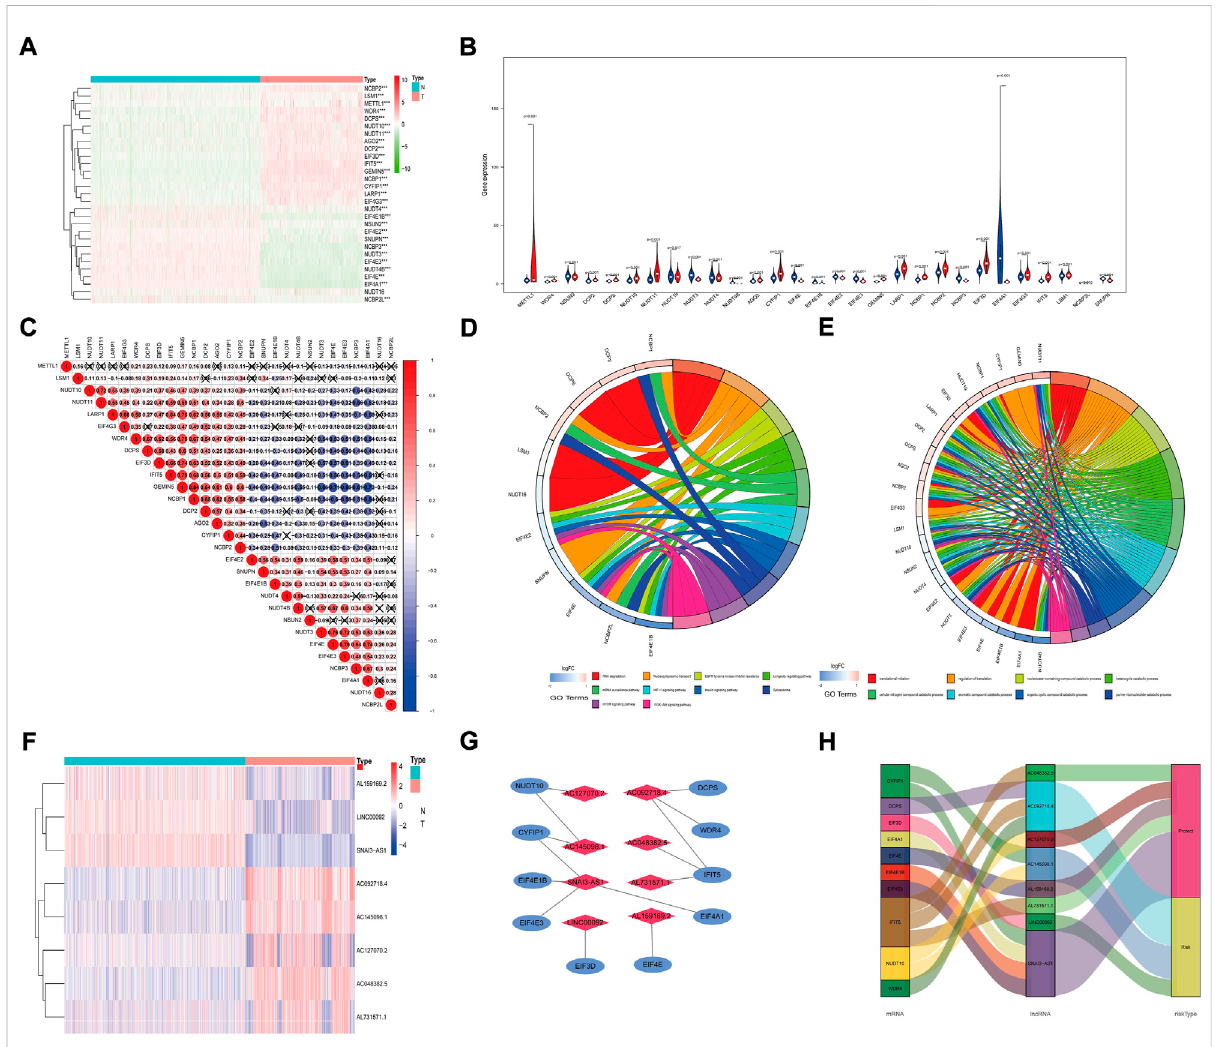
FIGURE 1 Expression of m 7 G-related mRNAs and prognostic m 7 G-Related lncRNAs. (A) Heat Map shows the expression levels of eight m 7 G-related mRNAs. (B) The vioplot shows the differentially m 7 G-related mRNAs. Blue represents normal sample, and red represents the glioma sample. (C) Spearmancorrelationanalysisofm 7 G-relatedmRNAs. (D) KEGGcirclediagramofm 7 G-relatedDEGs. (E) GOcirclediagramofm 7 G-relatedDEGs. (F) The expression levels of eight prognostic m 7 G-Related lncRNAs. (G) The co-expression network of prognostic m 7 G-related lncRNAs. (H) Sankey diagram of prognostic m 7 G-Related lncRNAs. lncRNAs, long non-coding RNAs; N, normal; T,